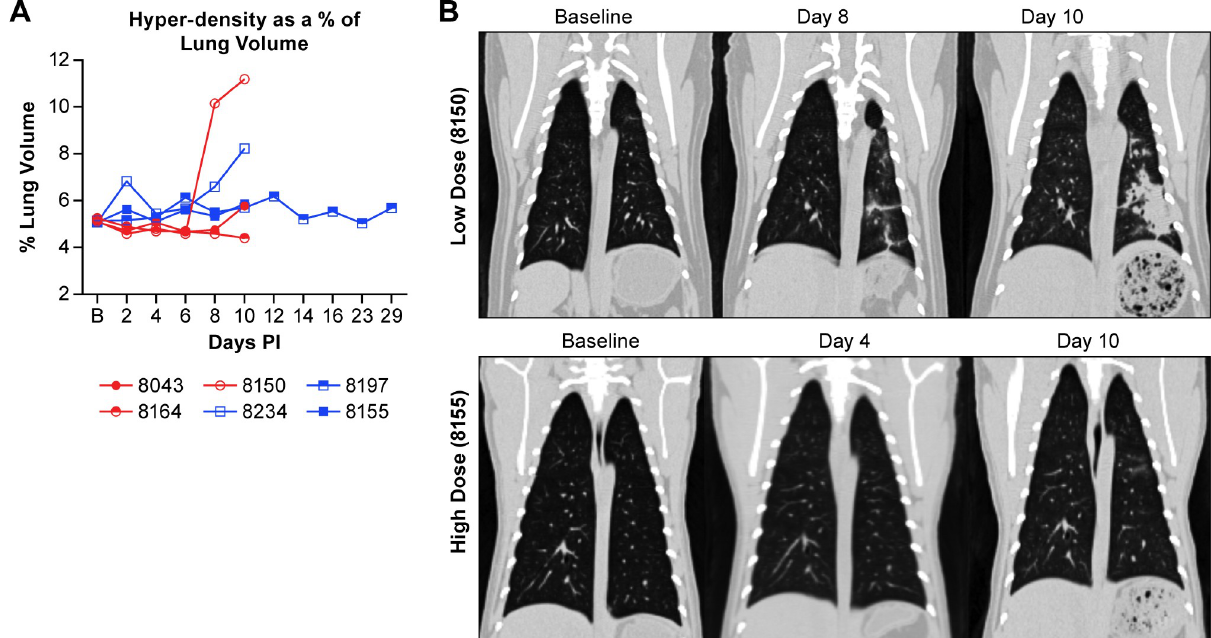
Fig 2. Evaluation of lung volume in NiV infected AGMs. Computed tomography (CT) scans were performed prior to NiV aerosol exposure (Baseline- B) and every second day following. Changes in lung volume (A) were quantified based on mapping of post-exposure images to pre-exposure baseline scans as previously described [22]. Volumetric quantification was calculated based on Hounsfield unit thresholds using histograms to determine threshold values. (B) Examples of CT images from two animals at the specified days post-virus exposure. The top panels demonstrate increased hyperdensity and a decrease in uninvolved lung volume while the lower panels show an animal that had minimal pulmonary changes based on CT.